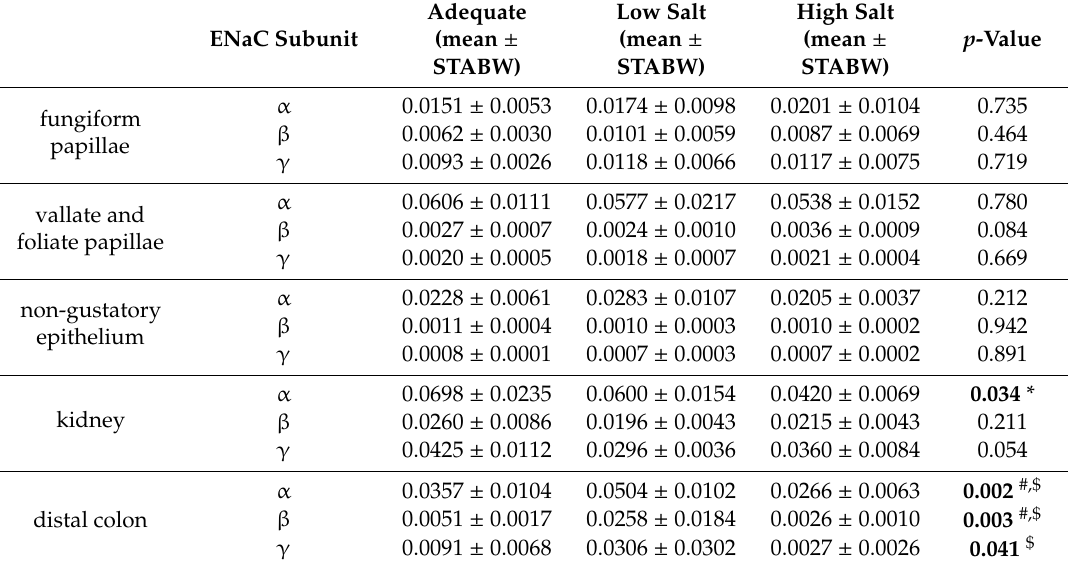
Table 1. Relative expression of epithelial sodium channel (ENaC) subunits in Scnn1 aa / bb mice after dietary intervention. Based on quantitative RT-PCR, the relative expression levels of ENaC subunits normalized to the housekeeping genes β -actin and eEf2 in isolated taste buds and non-gustatory tissue were determined. Data represent the means of 6 Scnn1 aa / bb mice, fed with sodium-adequate, low, or high salt diet over a period of 4 weeks. Statistical testing is based on UNIANOVA and post-hoc analysis using Bonferroni´s multiple comparison test. p -Values rely on comparison of all groups with significant di ff erences indicated in bold; individual di ff erences between the di ff erent diets are additionally indicated as the following: * statistical significance between sodium-adequate and high salt diet; # statistical significance between sodium-adequate and low salt diet; $ statistical significance between low and high salt diet based on Student´s t